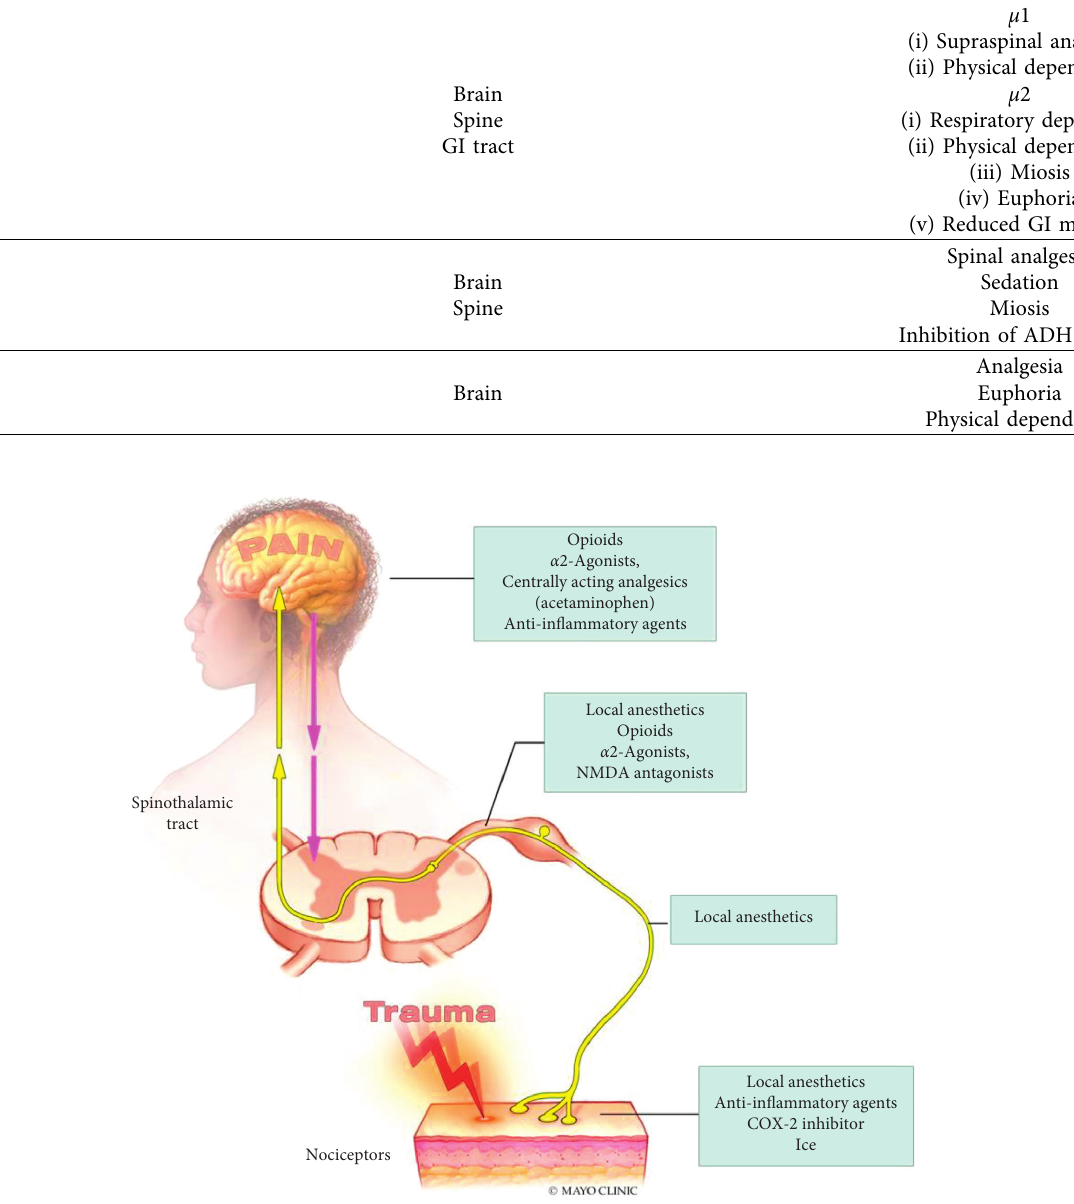
Figure 1: Analgesic sites of